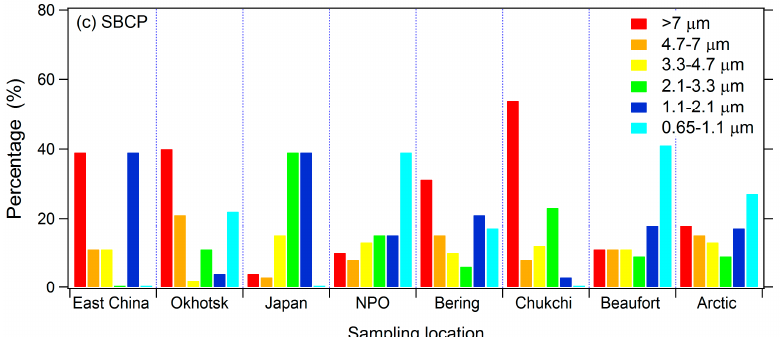
Figure 2. Distribution plot for ( a ) total airborne bacteria-containing particles (TBCPs); ( b ) non-salt tolerant airborne bacteria-containing particles (NSBCPs); and ( c ) salt tolerant bacteria-containing particles (SBCPs) fraction over each region.